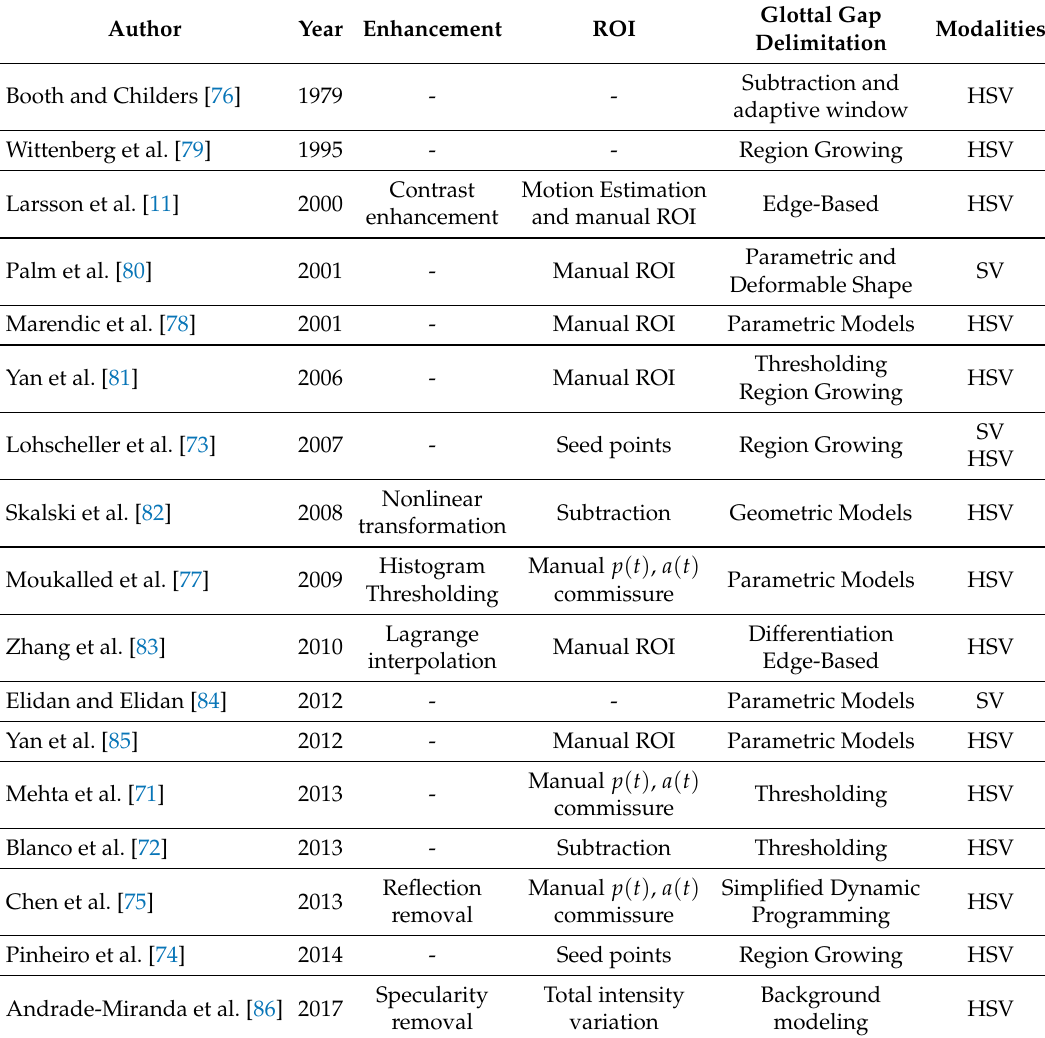
Table 1. Summary of the main semi-automatic studies carried out to segment the glottal gap. First column corresponds to the authors. Second, year of publication. Third, enhancement technique. Fourth, Region of Interest (ROI) detection. Fifth, segmentation algorithm. Sixth, laryngeal image